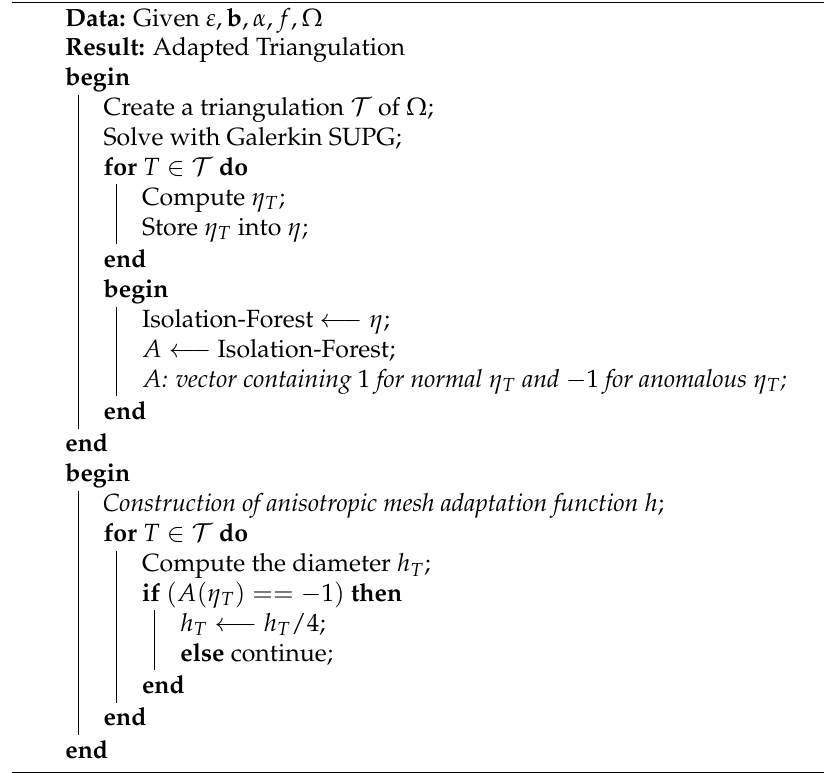
Algorithm 1: Pseudo-code for the proposed